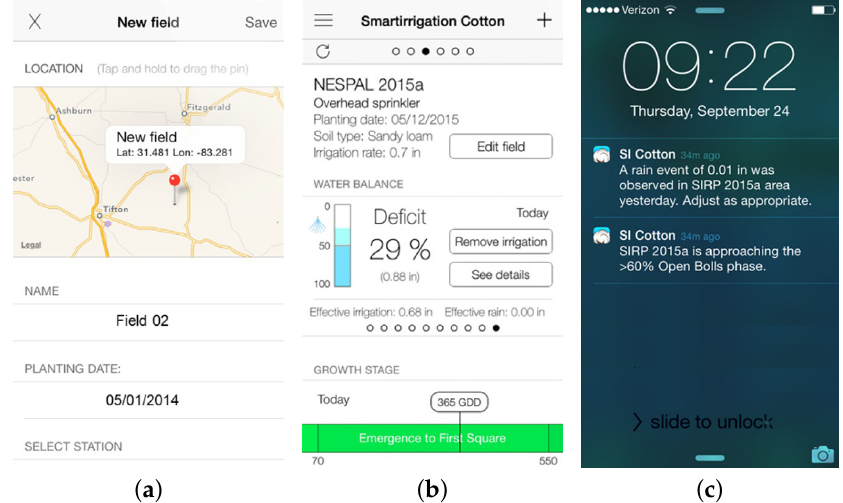
Figure 16. Smartirrigation Cotton: ( a ) Pin field location on map; ( b ) Main user-interface screen; ( c ) Notifications about rain and phenology change.